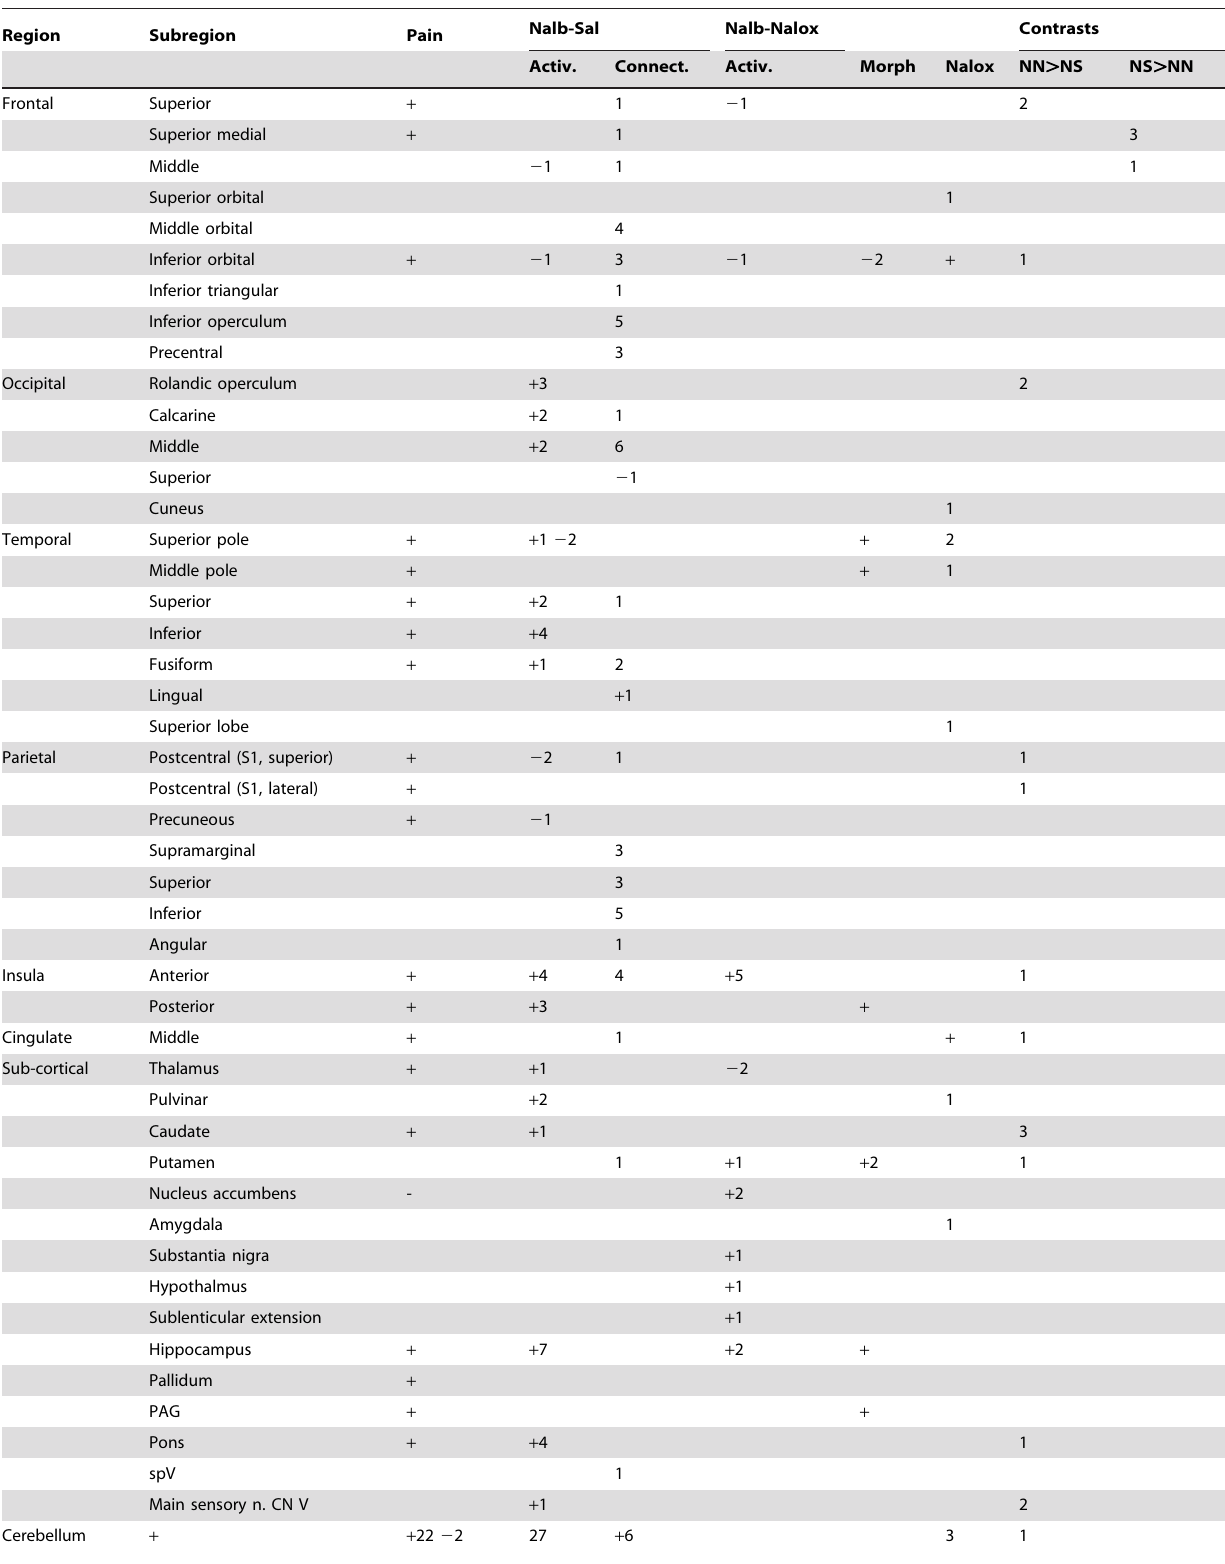
Table 5. Comparison with drug actions in other studies.